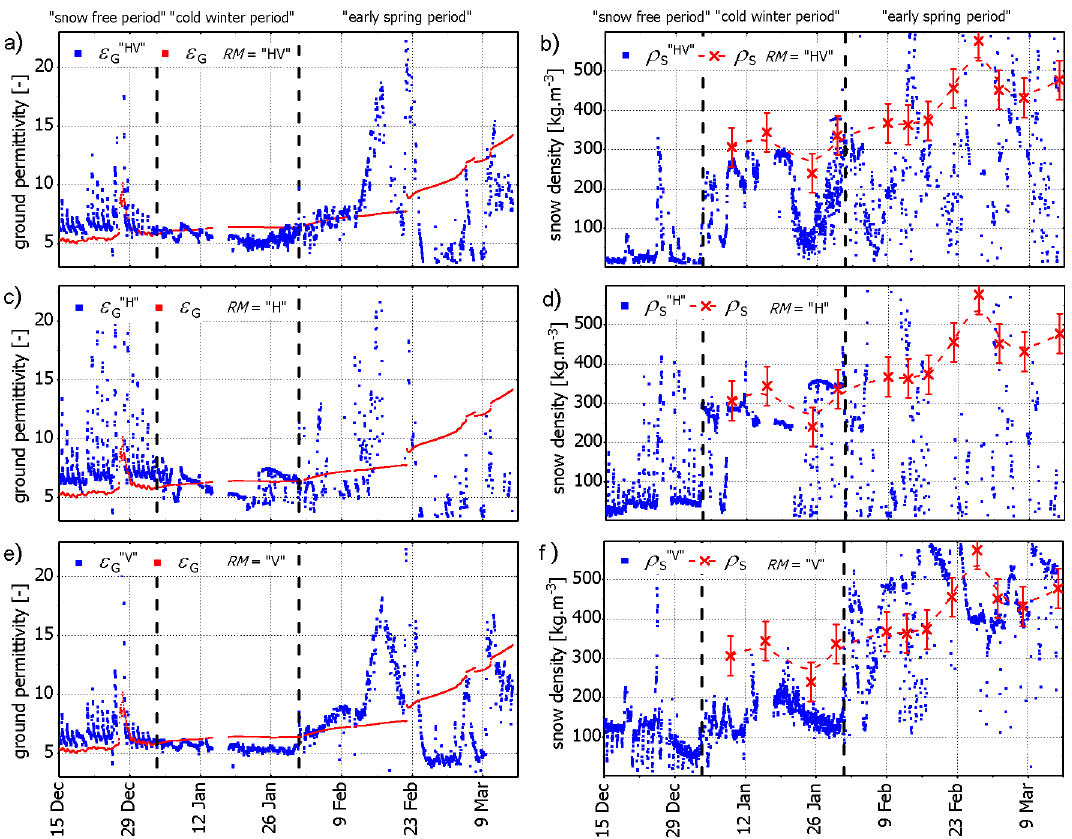
Figure 6. Multi-angle two-parameter retrievals P RM = ρ RM , ε RM for the time period 15 December, 2016–15 March, 2017. Panels ( a , b ) show the time series of ε “HV” and ρ “HV” , respectively. Panels ( c , d ) and ( e , f ) show corresponding ε RM and ρ RM for RM = “H” and “V”, respectively. Red markers show in-situ measured bottom-layer snow density ρ S and ground permittivity ε G (same data as shown in Figure 2). The vertical dashed lines delimit the “snow-free period” (before 3 January), the “cold winter period” (3–31 January), and the “early spring period” (after 31 January).